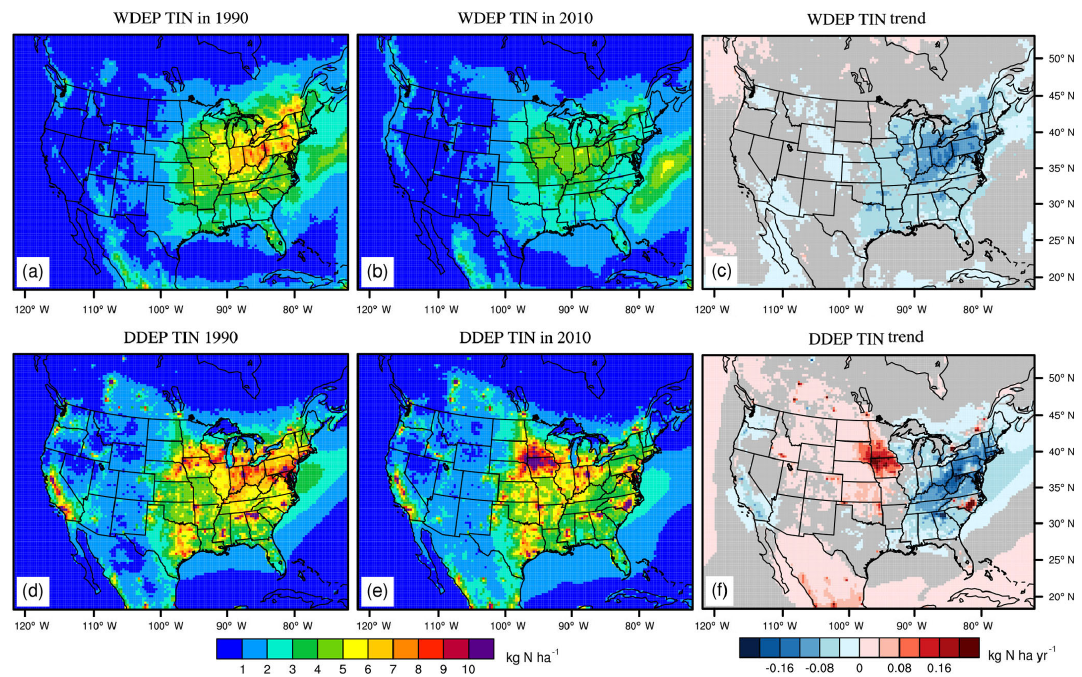
Figure 6. Spatial distribution of WDEP ( a – c ) and DDEP ( d – f ) of TIN (kgNha − 1 ) in 1990 (a, d) , 2010 (b, e) , and the simulated trends ( c , f , kgNha − 1 yr − 1 ) over the 2 decades. Grey areas on the right plot show p value great than 0.05 for the standard two-tailed Student t test (i.e., areas where trend estimates were not significant at the 95% confidence level).